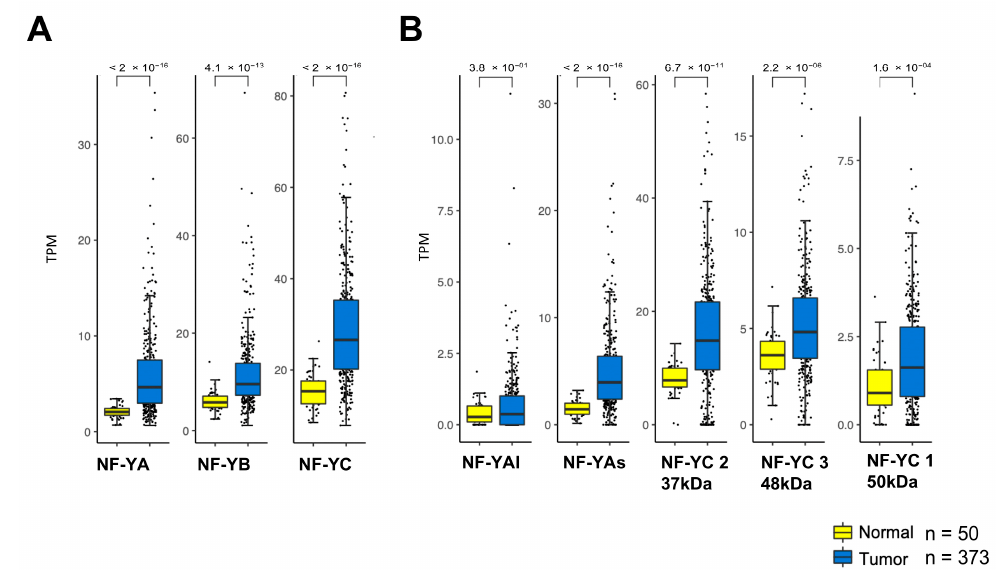
Figure 1. NF-Y subunits are overexpressed in HCC (Hepatocellular Carcinoma). ( A ) Box plots of Figure 1. NF ‐ Y subunits are overexpressed in HCC ( Hepatocellular Carcinoma). ( A ) Box plots of expression levels of the three NF-Y subunits at gene level in the TCGA-HCC dataset, measured in expression levels of the three NF ‐ Y subunits at gene level in the TCGA ‐ HCC dataset, measured in TPMs (Transcript per Millions). ( B ) In the same way as A, the NF-YA—NF-YAs, NF-YAl—and NF-YC TPMs (Transcript per Millions). ( B ) In the same way as A, the NF ‐ YA — NF ‐ YAs, NF ‐ YAl — and NF ‐ isoforms levels were YC isoforms levels were analyzed.